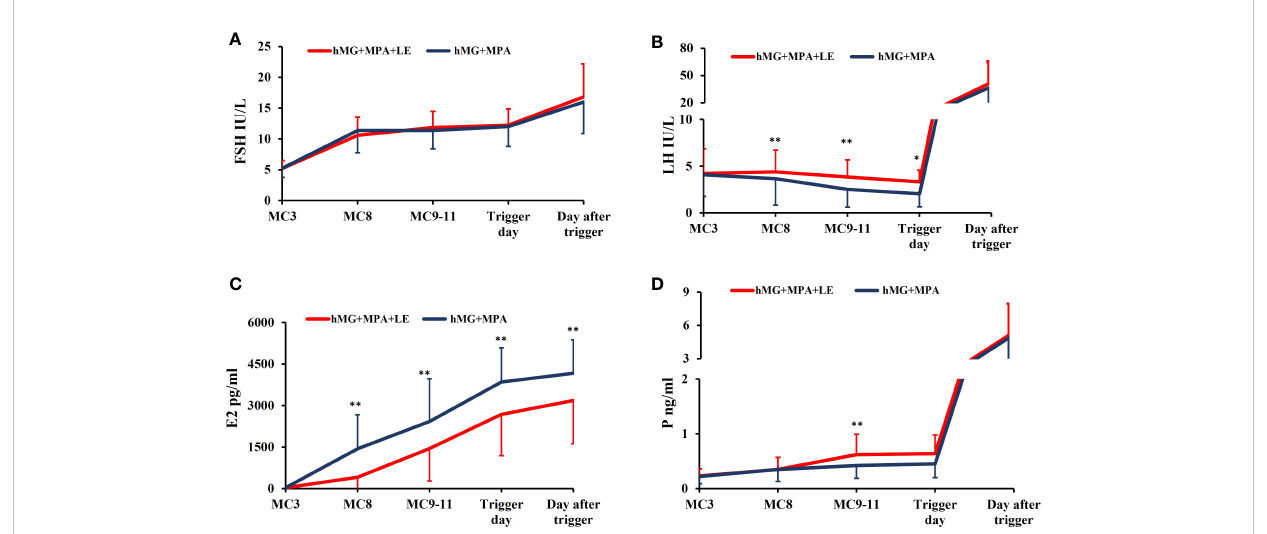
FIGURE 2 The dynamic changes in hormones during ovarian stimulation in the two groups. (A) . Serum FSH levels in the two groups during COS. (B) . Serum LH concentration in the two groups during COS. (C) . Serum E2 level in the two groups during COS. (D) Serum P levels in the two groups during the COS. The solid red lines represent the study group (hMG+MPA+LE) and the solid heavy blue lines represent the control group (hMG+MPA). The asterisks denote signi fi cant changes in hormone levels at the indicated time points (*P <.05, **P